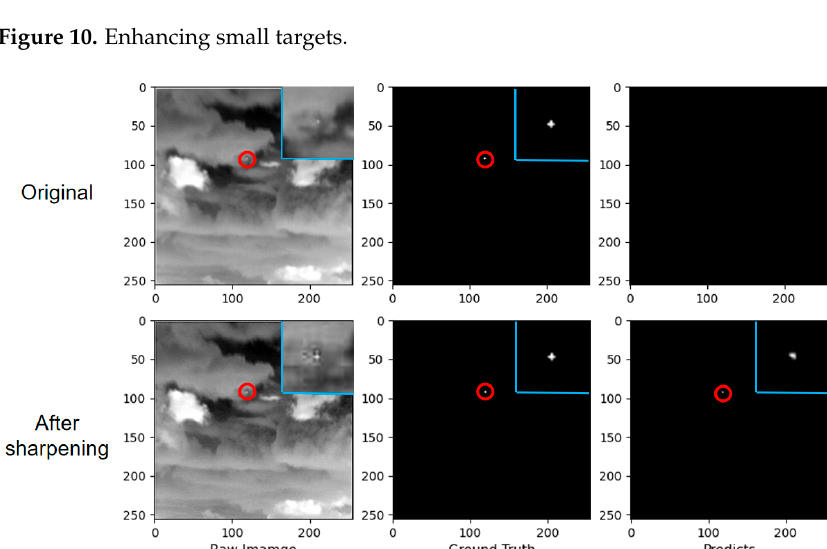
Figure 11. Detection results before and after sharpening.